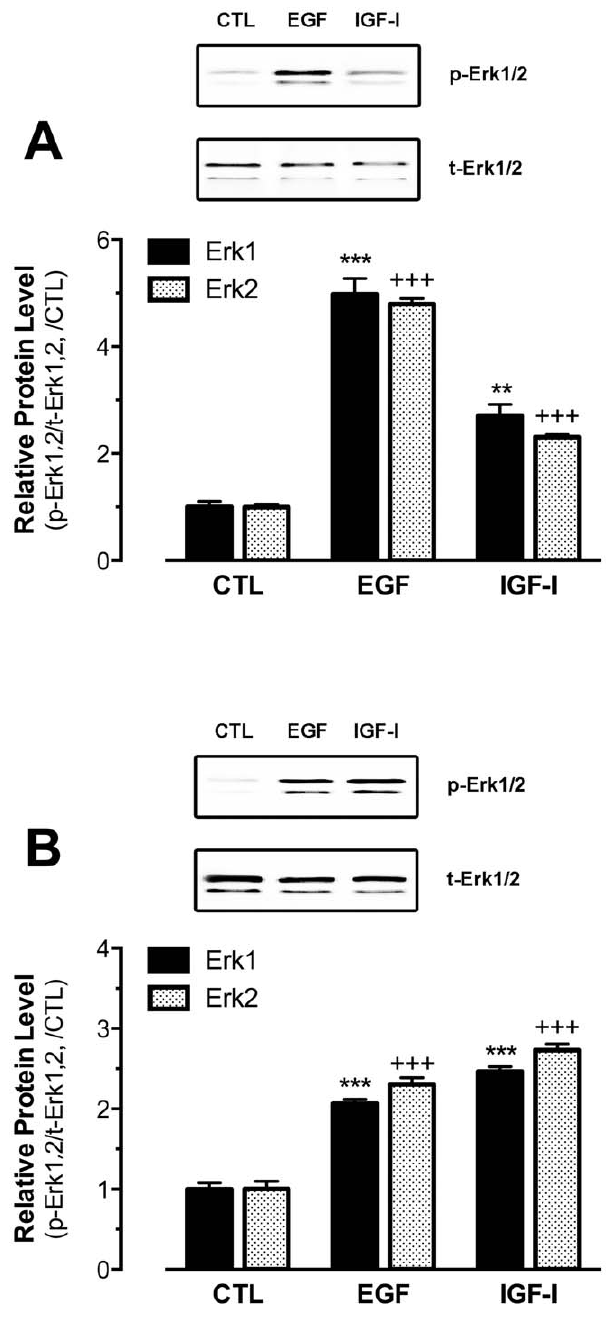
Figure 9. Effects of EGF and IGF-I on MAPK phosphorylation in immature intact follicles or ovulated mature oocytes. The immature intact full-grown follicles (A) or ovulated mature oocytes (B) were treated with human EGF or IGF-I for 10 min followed by Western blot analysis for MAPK (Erk1/2) phosphorylation. The Western blot image is shown on the top of each graph and the densitometric quantification is at the bottom. The data were normalized to the total Erk1 or Erk2 and expressed as the fold change compared to the control (CTL) (mean 6 SEM, n=3). **/ ++ P , 0.01; ***/ +++ P , 0.001. p-Erk1/2, phosphorylated Erk1/2; t-Erk1/2, total